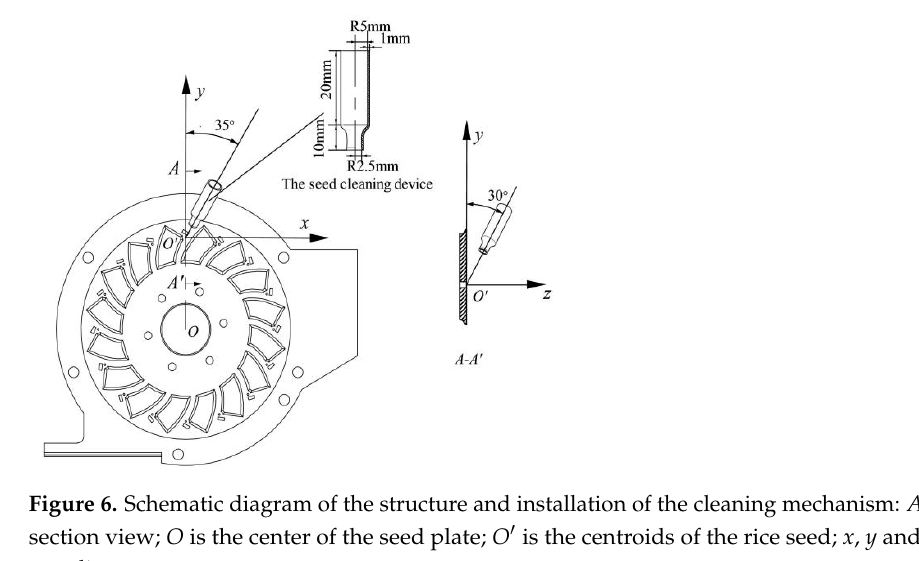
Figure 8. Three kinds of curves. 3.2. Simulation Model Construction In order to analyze the influence of the three shrinkage curves on the distributions of the pressure and velocity in the flow field, Fluent software (ANSYS, Inc., Canonsburg, PA, USA) was used to simulate the flow field. Figure 9a shows the simulation model, wherein the inlet is a cylinder with a diameter of 10 mm and a length of 10 mm and the length of the nozzle is 10 mm in order to ensure stable flow. In order to fully observe the airflow from the nozzle, a cylinder with a diameter of 30 mm and a length of 100 mm was selected for the external flow field. Figure 9b shows the simulation mesh. Due to the regular shape of the nozzle, a hexahedral mesh was used to improve the simulation’s efficiency. The number of mesh nodes for the three nozzle structures was about 230,000 and the number of meshes was about 260,000. The pressure inlet was selected for the inlet and the air pres- sure was set to 0.15 kPa, according to the previous test. The right side was the external flow field area, which was set as the pressure outlet, and the air pressure was the standard atmospheric pressure of 0 kPa. The working process of the seed cleaning nozzle belongs to the category of jet flow. In order to better simulate the air movement conditions, the k– ω turbulence model was selected. Considering the narrow nozzle flow channel and the existence of near-wall effects, the SST (Shear Stress Transfer) k– ω turbulence model was used.